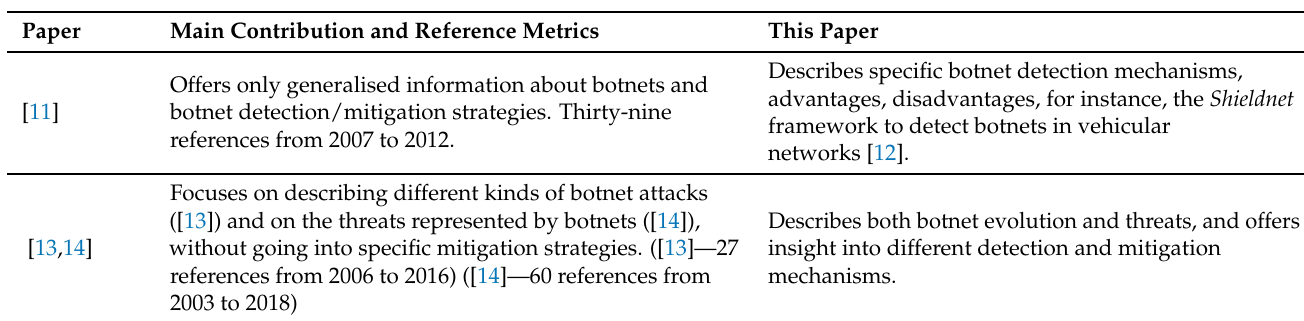
Table 1. Novelty of this paper with respect to related surveys. Number of references within each research question and year range is compared with the contribution of this paper to quantitatively show the novelty of this paper (years: 2006–2021, incentives: 13 references, evolution: 33, detection/mitigation: 134, trends/challenges: 41). For rows with multiple